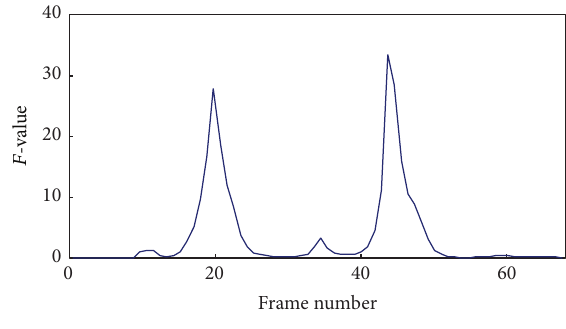
Figure 1: 𝐹 -curve schematic diagram.